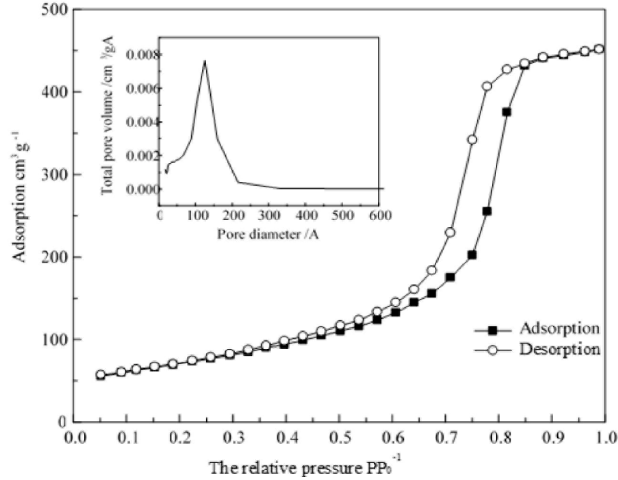
Figure 6. Nitrogen adsorption/desorption isotherms of γ -Al 2 O 3 (inset shows pore diameter distribution).